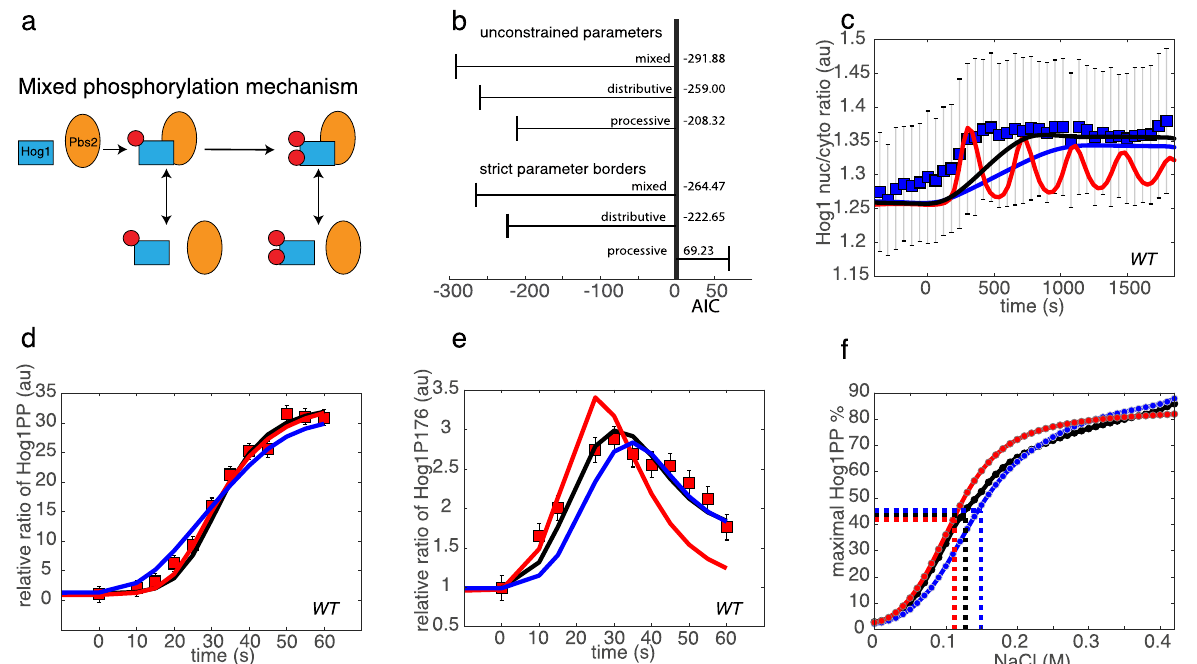
Fig.3|TemporaldynamicsofmonophosphorylatedHog1supportmodelswith partially distributive phosphorylation. a A mixed phosphorylation mechanism generates a phosphorylation reaction with both distributive and processive char- acter. b Akaikeinformationcriterion(AIC)ofthebest fi tsaftertheoptimizationand fi tting with unconstrained parameter values or stricter boundaries that approx- imate physiological conditions (see Supp Fig. S4). Note, that in contrast to the re fi nedmodelofFig.2b,datafrommono-phosphorylatedHog1specieswasusedin the fi tting and the resulting fi t thus the best fi tting model on all data. Simulations are shown of selected Hog1 species from the three best fi tting models in which all models incorporate positive and negative feedbackinwild-type cells (WT). Graphs show experimental data points used for parameter optimization (red square) and testing(bluesquare),aswellassimulationresultsfromthebest fi ttingmixed(black line), processive (red line) or distributive (blue line) Hog1 phosphorylation mechanism in response to salt stimulation. c Time course of Hog1 nuclear to